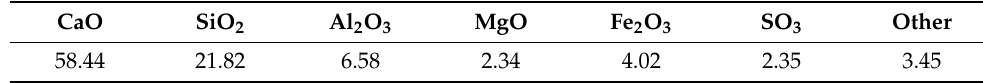
Table 1. Chemical composition of cement (%).